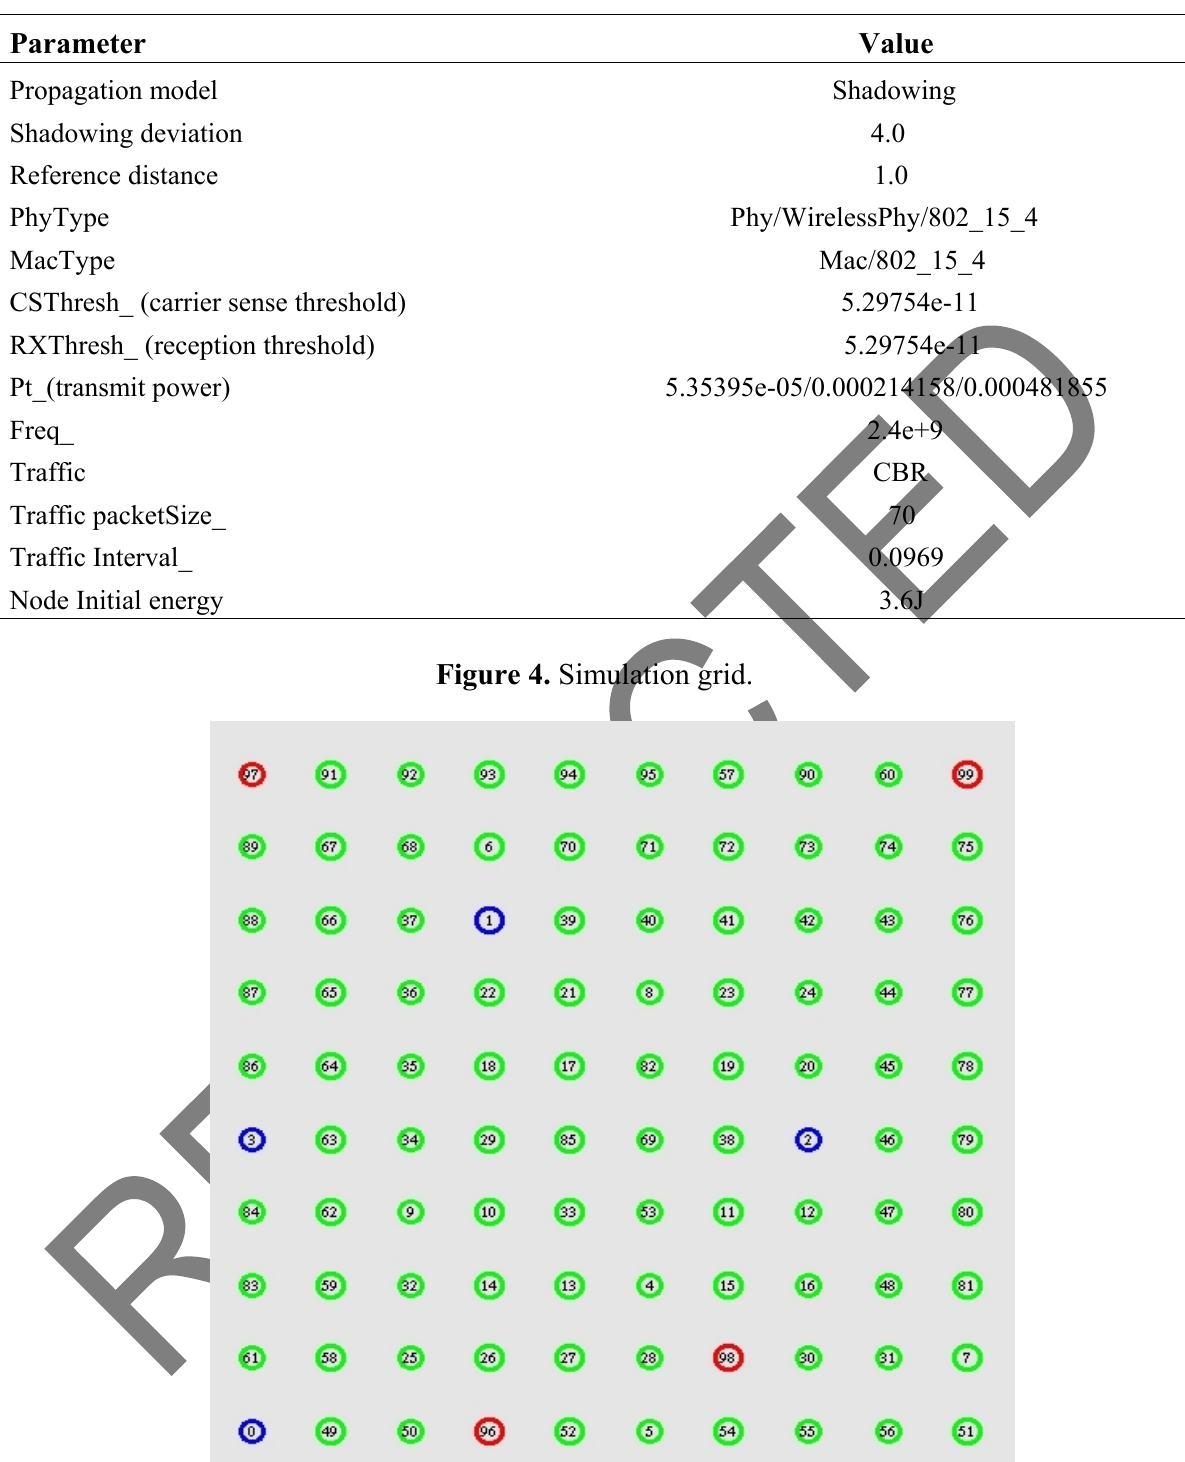
Figure 4. Simulation